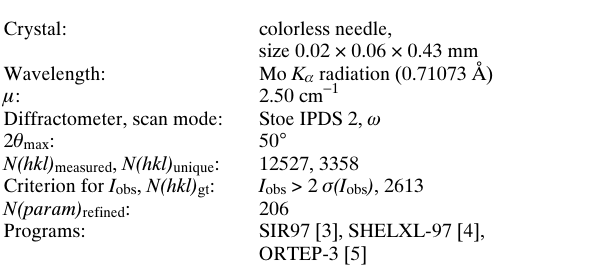
Table 1. Data collection and handling.